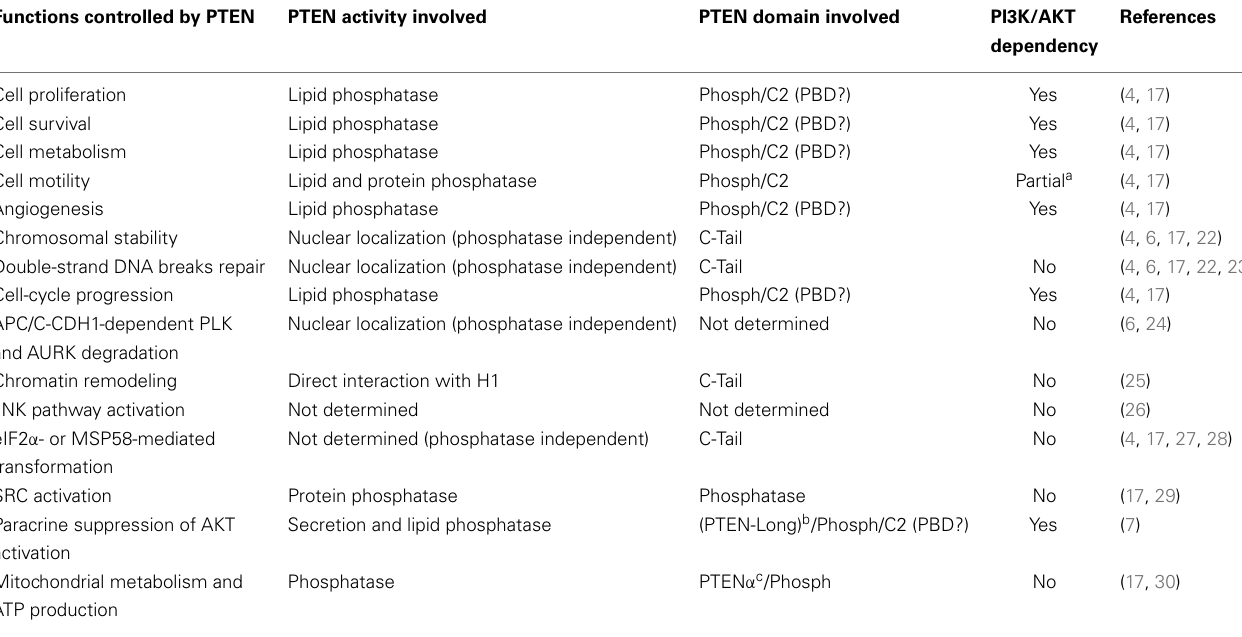
Table 1 | Selected cell functions controlled by specific PTEN activities/domains and their dependency on regulation of the PI3K pathway . Functions controlled by